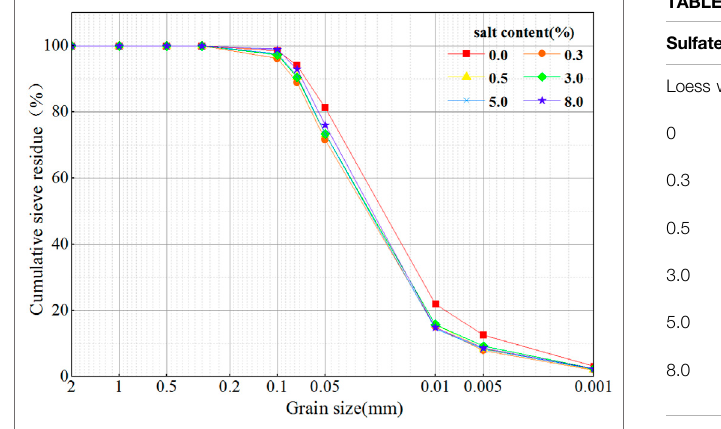
FIGURE 2 | Particle size distribution graph of different sulfate content in saline